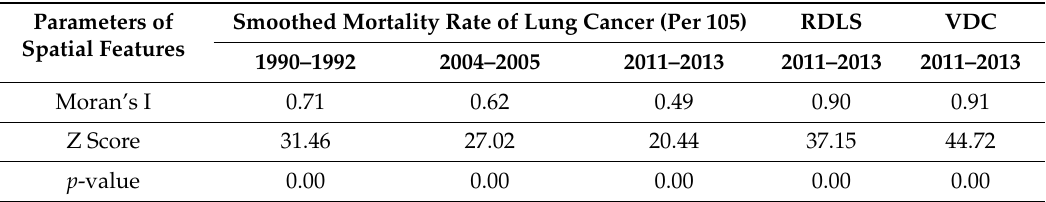
Table 2. Spatial autocorrelation of the village-level mortality rate and dwelling condition. Parameters of Spatial Features